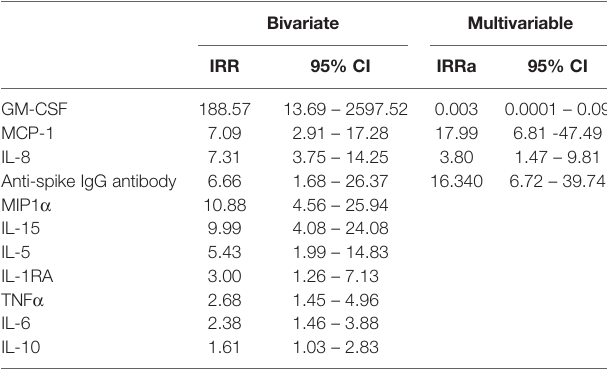
TABLE 2 | Bivariate and Multivariable regression analysis of biomarkers associated with death in hospitalized COVID-19 male patients. Bivariate Multivariable IRR 95% CI IRRa 95%